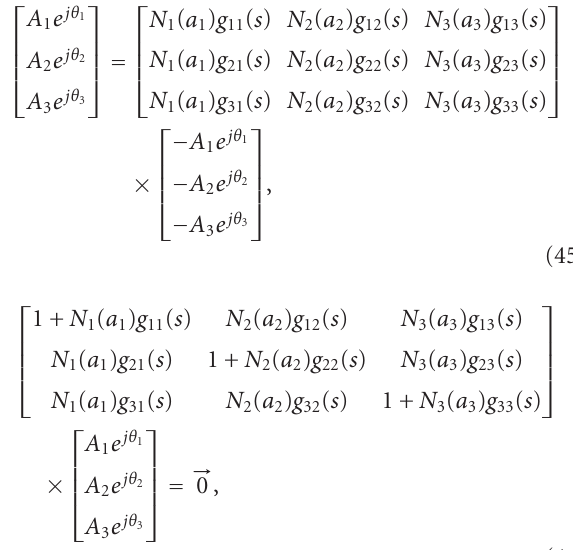
Figure 11: Time responses of Example